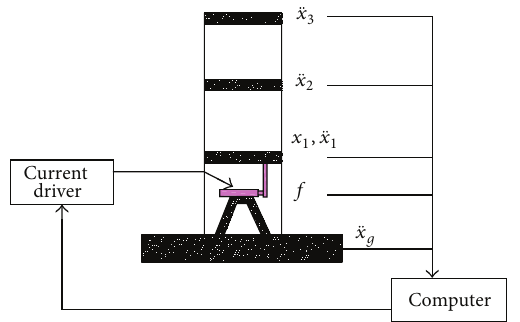
Figure 3: Schematic representation of an MR damper implemented in a three-story building.